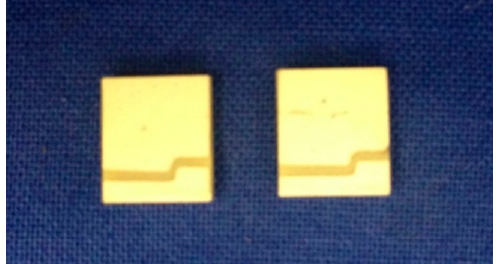
Figure 1. The photo of two PZT patches.